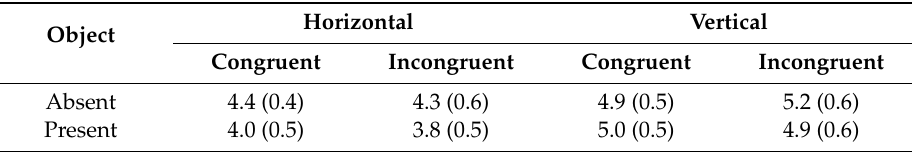
Figure 3. Mean reaction time results from Experiment 2. OA = object-absent trials; OP = object-present trials. Table 2. Mean error rates (percent incorrect) as a function of object, target configuration orientation, and cue-target congruency in Experiment 2. Within-subject standard errors are in the